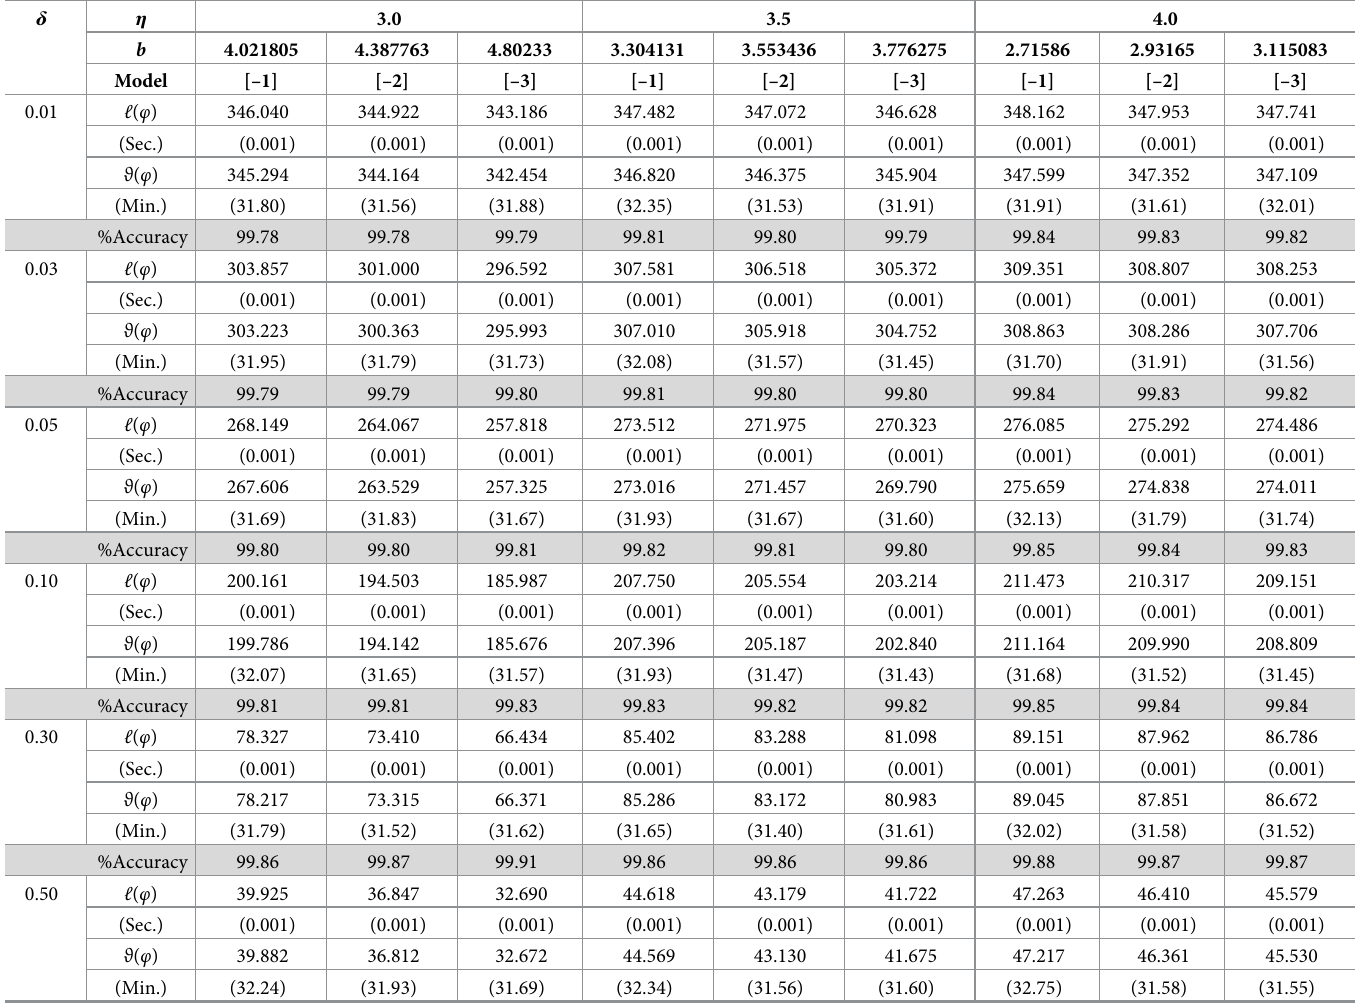
Table 3. Comparison of the ARL 1 values obtained using the analytical and numerical ARL methods for long-memory SARFIMAX( P , D , Q , r ) nential white noise on a CUSUM control chart for ARL 0 = 370 with F 1 = − 0.1, F 2 = 0.2, Θ 1 = 0.1, and ω 1 = 0.5. δ